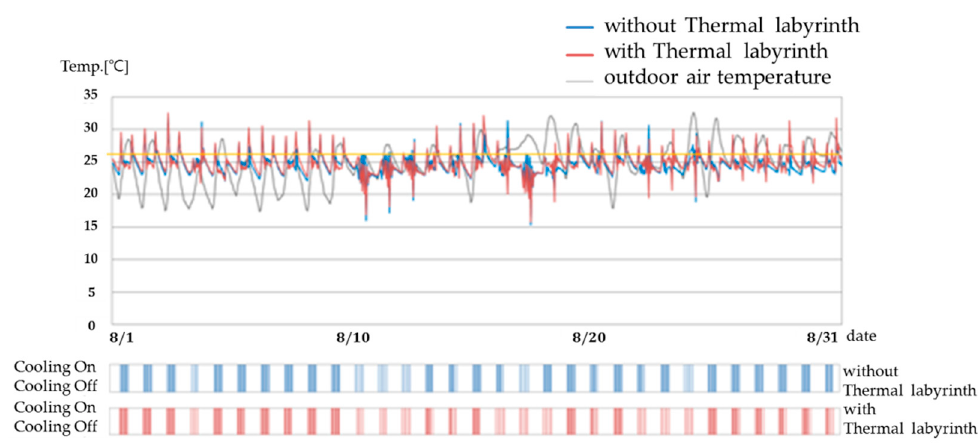
Figure 17. Outdoor and indoor air temperature distributions during cooling.